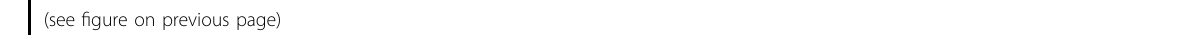
Fig. 2 Radiation induced TBK1 expression and knockdown of TBK1 attenuates radiation-induced EMT. a , b Representative western blots and densitometric quanti fi cation of TBK1 protein levels at different times and with different radiation doses. c Immuno fl uorescence staining for TBK1 (green) and DAPI (blue) in nonirradiated control and irradiated cells at 1 h postirradiation. Scale bar represents 50 μ m. d Representative western blot and densitometric quanti fi cation of TBK1 following infection with TBK1-speci fi c shRNA lentivirus to con fi rm target suppression. e Phase contrast microscopy images of cells expressing TBK1-speci fi c shRNA and control shRNA at 48 h after 8 Gy irradiation. Scale bar represents 100 μ m. f Western blot analysis of E-cadherin, vimentin, and α -SMA expression in TBK1 knockdown RLE-6TN cells. GAPDH was used as the loading control in all the above western blot analyses. All data are presented as the mean ± SEM ( n = 3). * P < 0.05 and ** P < 0.01 vs. nonirradiated